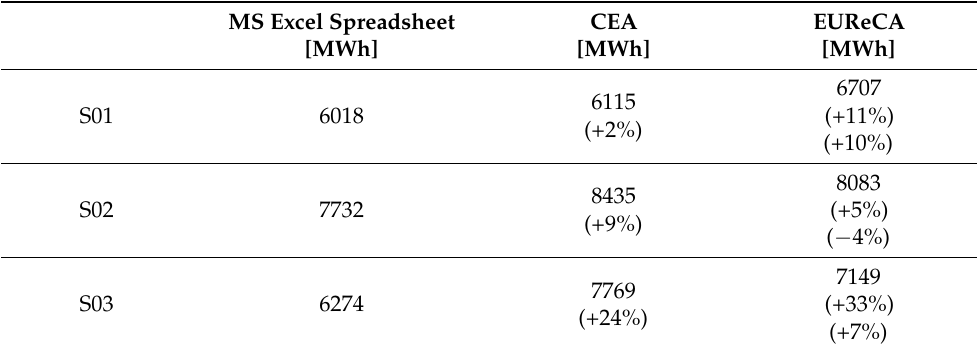
Table 4. Total district energy demand [MWh]: blue percentage compares to the quasi-steady-state method, red percentage compares the two dynamic